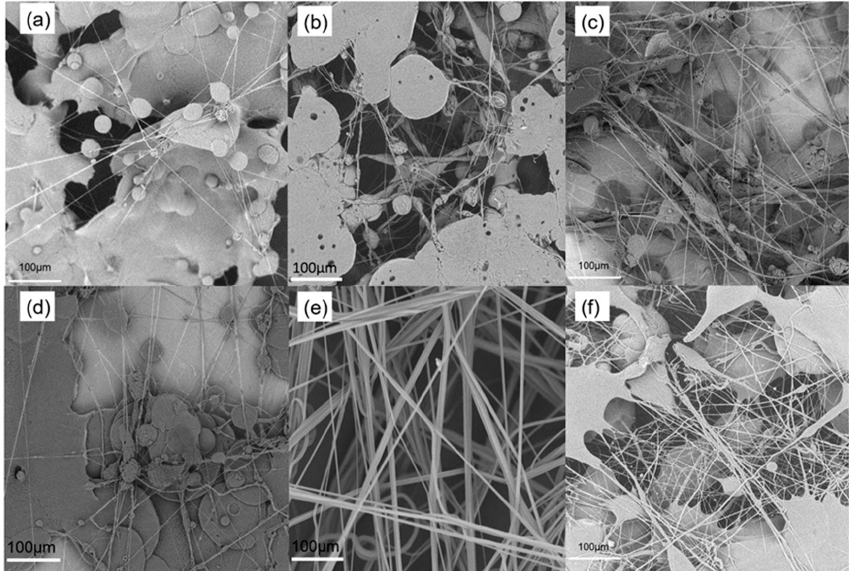
Figure 2. SEM for different concentrations and solvents of PVDF: ( a ) DMF/15 wt%, ( b ) DMF/20 wt%, ( c ) DMF/25 wt%, ( d ) DMF-acetone/15 wt%, ( e ) DMF-acetone/20 wt%, and ( f ) DMF-acetone/25 wt%. ( c ) DMF / 25 wt%, ( d ) DMF-acetone / 15 wt%, ( e ) DMF-acetone / 20 wt%, and ( f ) DMF-acetone / 25